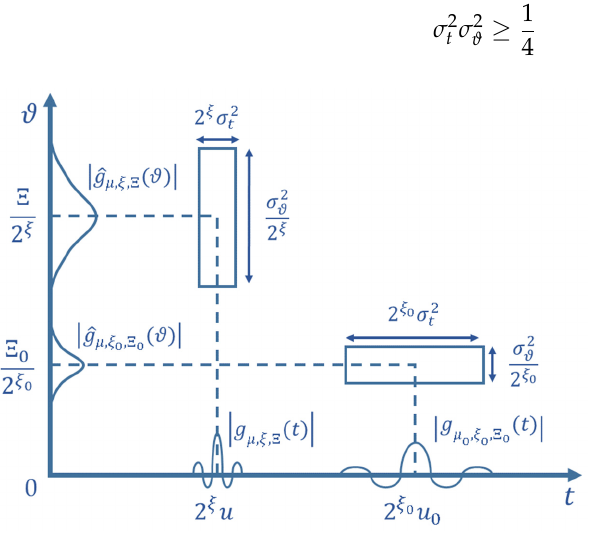
Figure 2. Time-frequency representation of wavelets.